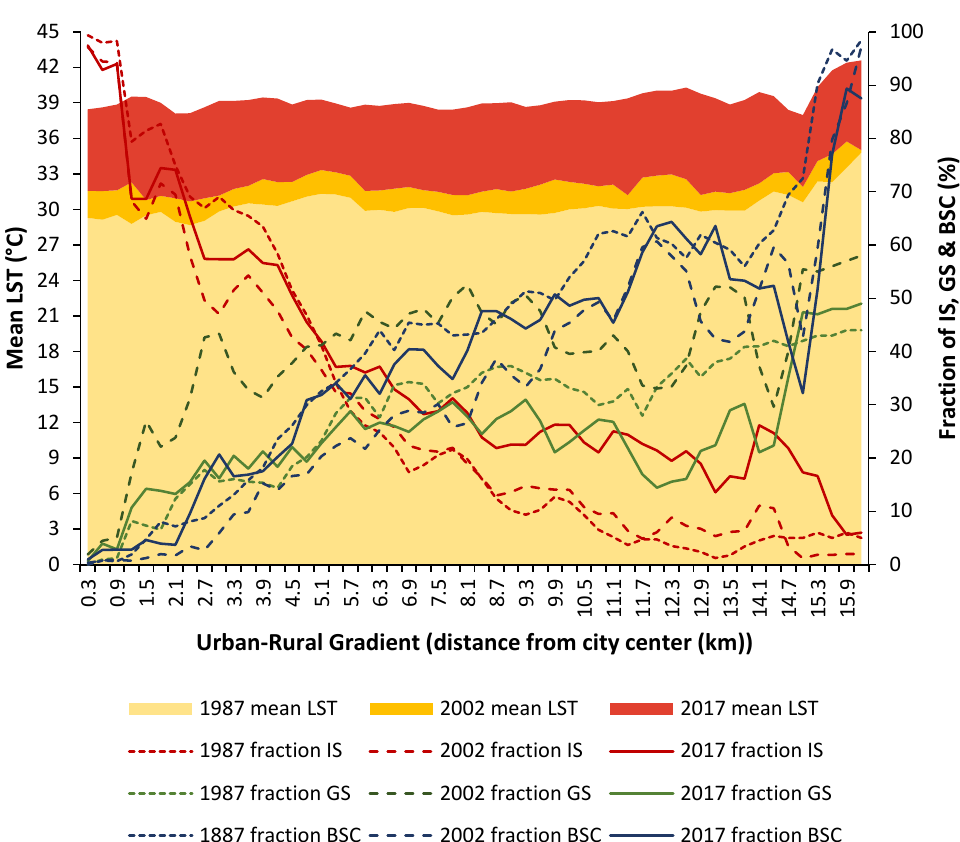
Figure 5. Mean LST of the LULC classes in Seville City (1987, 2002 and 2017).